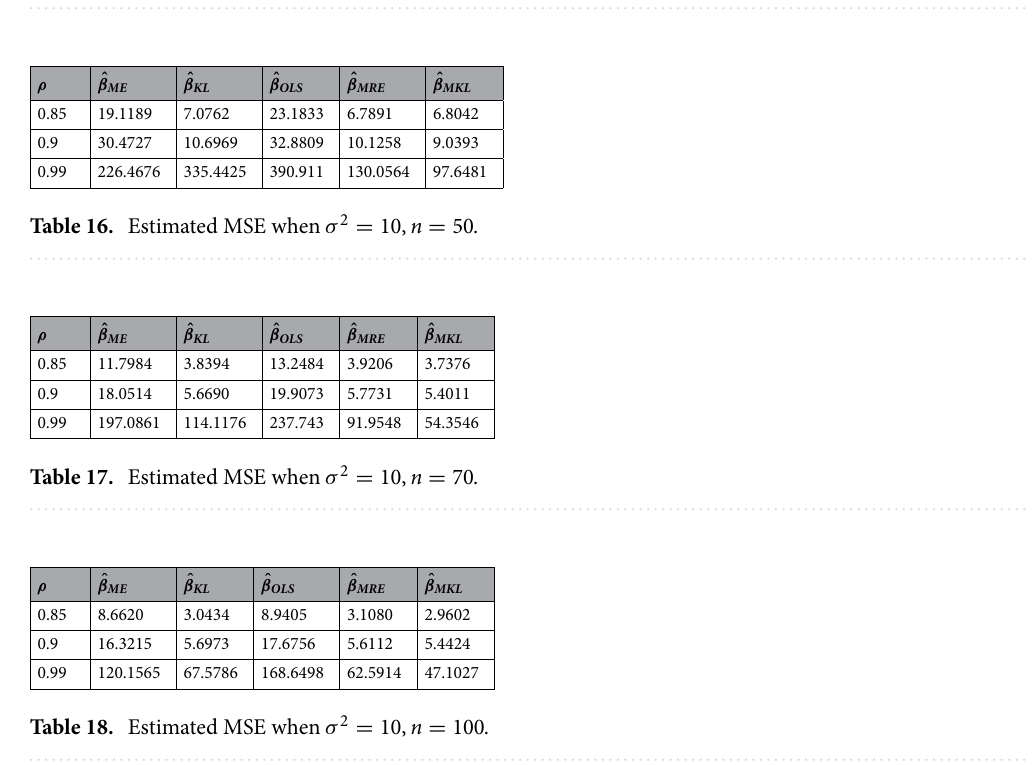
Table 15. Estimated MSE when σ